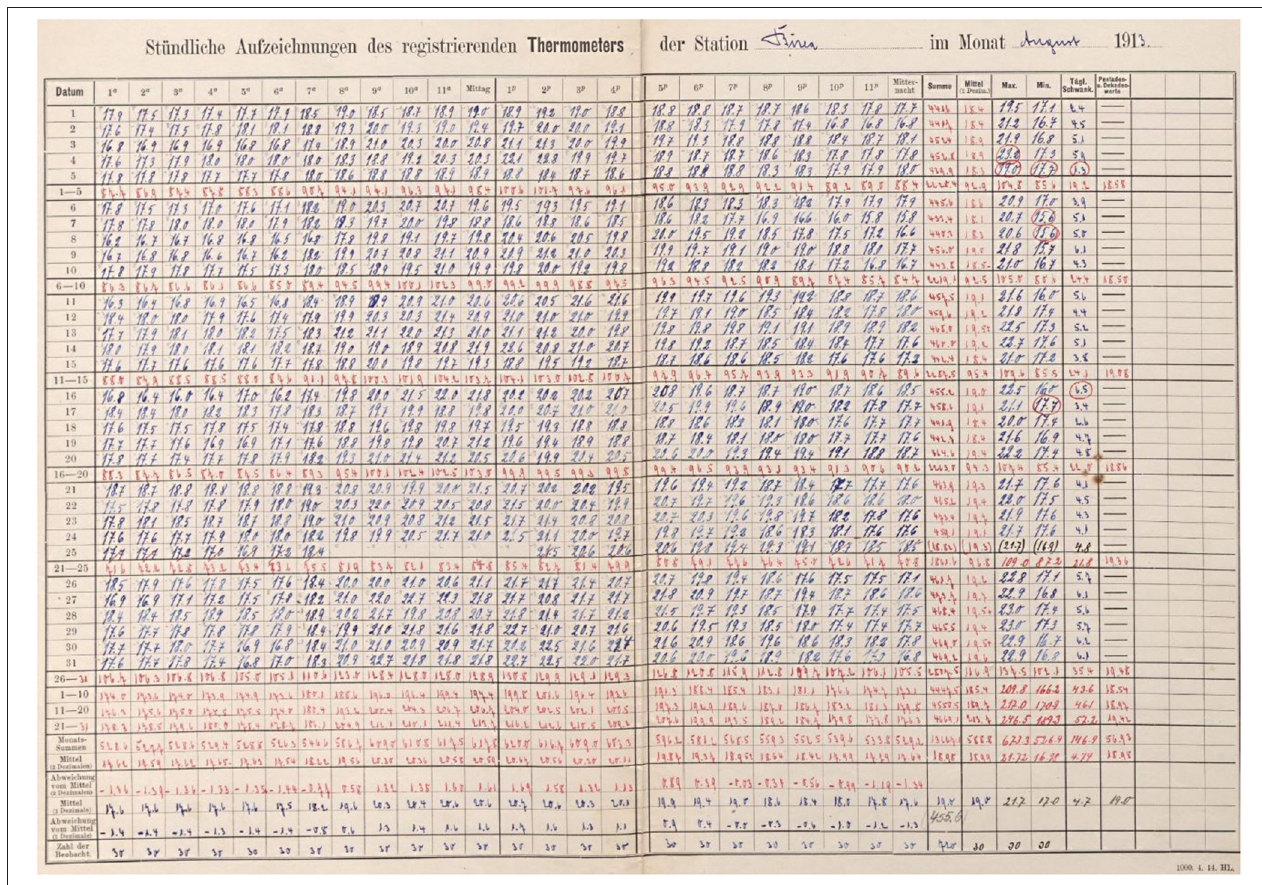
FIGURE 2 | Hourly observations of the recording thermometer (thermograph) at station Buea (Cameroon) in August